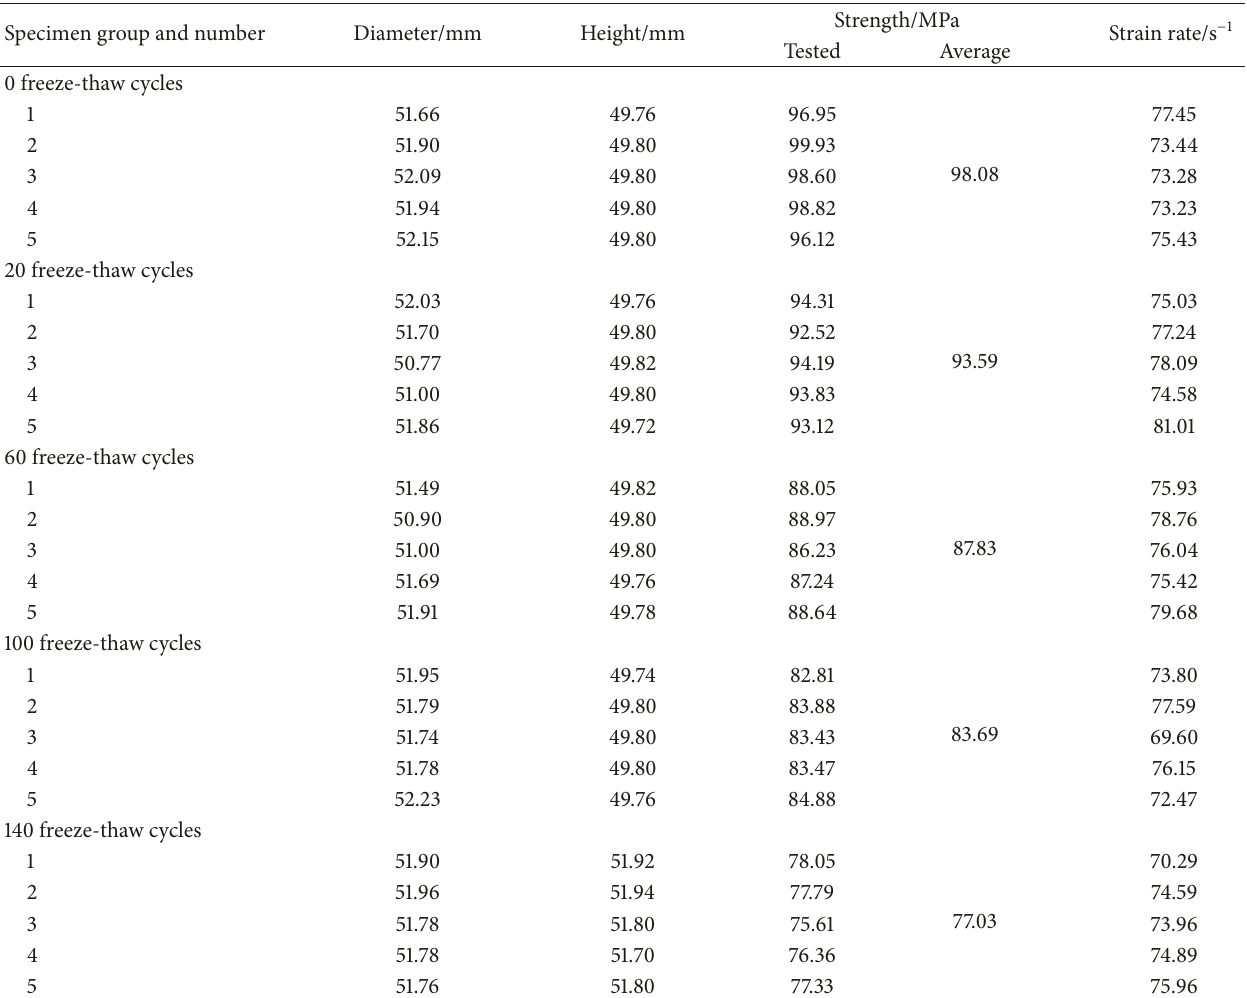
Table 3: Specimens parameters in dynamic compressive tests under different freeze-thaw